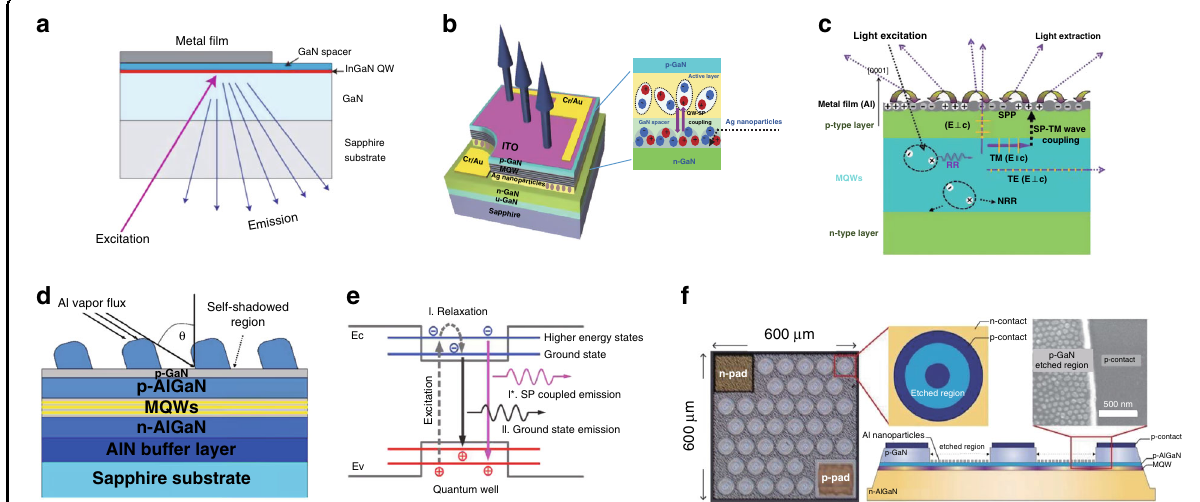
Fig. 10 Versatile metallic structures embedded into the LEDs and the schematically SP-enhanced illustration. a The sample structure of the SP-enhanced InGaN quantum wells by deposition of different metallic fi lms. b Schematic 3D representation of an InGaN/GaN LED with embedded Ag nanoparticles. Schematic illustration ( c ) of the SP enhanced and d the LSP enhanced DUV LEDs by ultrathin Al fi lm and Al nanoparticles, respectively. e A schematic diagram showing the transition mechanisms for ground state emission and SP-coupled hot carrier emission in an AlGaN MQW structure and f the DUV LED through LSP coupling resonance with a high-density array of Al nanoparticles formed in the etched region. Figures reproduced from a ref. 120 , © 2004 Springer Nature; b ref. 119 , © 2008 John Wiley and Sons; c ref. 125 , © 2012 Springer Nature; d ref. 126 , © 2014 Springer Nature; e ref. 127 , © 2014 John Wiley and Sons; f ref. 130 , © 2020 ACS